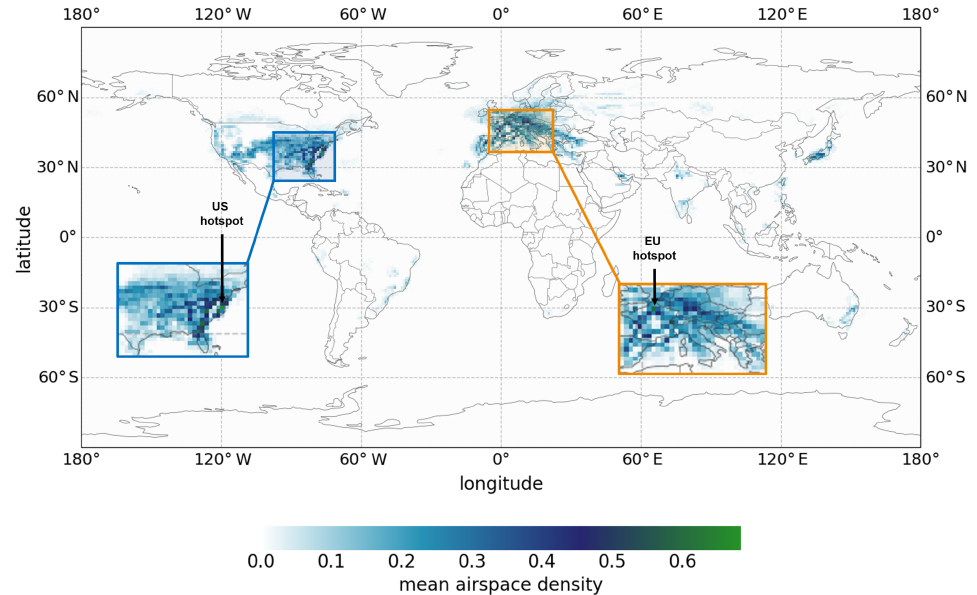
Figure 3. Global heatmap of mean air traffic density. Snapshots of air traffic data were taken at the first second of every hour throughout January 2022. Mean values are significantly lower than peak values due to large variations in aviation demand throughout the course of each